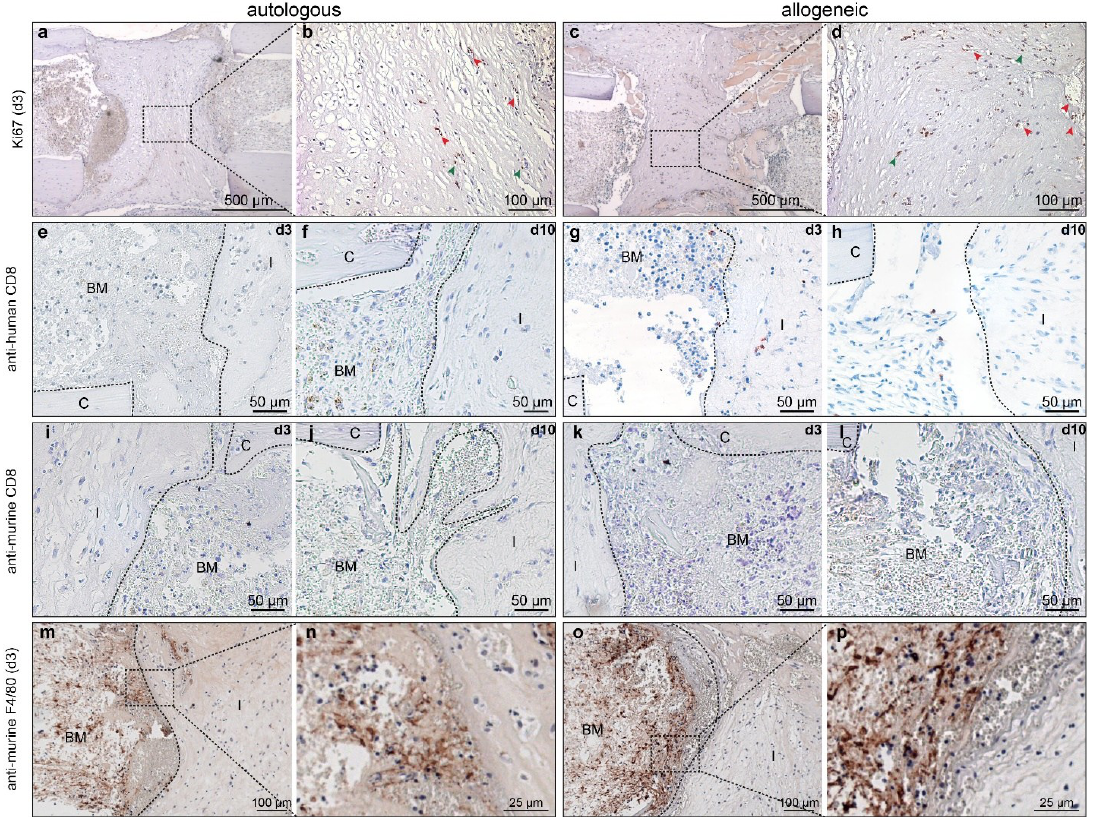
Figure 3. Immunohistochemical analysis of cell proliferation and inflammatory cells. ( a – d ) Staining of Ki67 on day 3 in mice with ( a , b ) autologous human mesenchymal stem cells (hMSC) treatment, and ( c , d ) with allogeneic hMSC treatment. ( e – h ) Staining for human CD8 on ( e , g ) day3 and ( f , h ) day 10 in mice with ( e , f ) autologous hMSC treatment and ( g , h ) allogeneic hMSC treatment. ( i – l ) Staining for murine CD8, the respective days are indicated in the upper right corner of the micrographs. ( m – p ) Staining of murine F4/80 in mice with ( m , n ) autologous hMSC treatment and ( o , p ) allogeneic hMSC treatment. BM: bone marrow; FT: fibrous tissue; C: cortical bone; I: implant. Dashed boxes indicate areas displayed in higher magnification. Red arrowheads in ( b , d ) indicate positive cells within vessel-like structures; green arrowheads indicate positive cells in the collagen gel matrix. Table 1. Cytokine/chemokine levels in pg/mL of serum obtained 3 days after surgery. Data are presented as the mean ± SD.